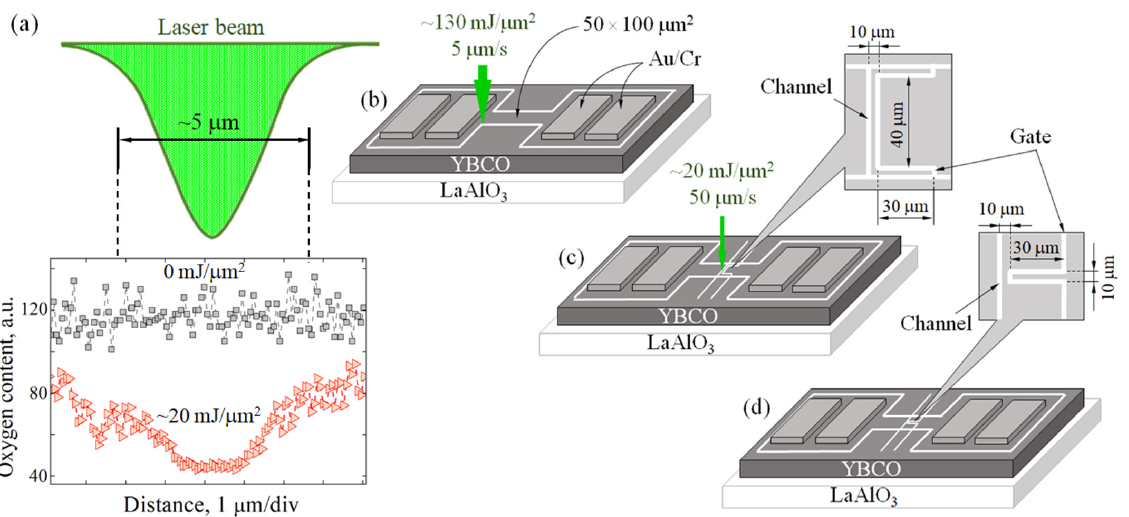
Figure 1. The partially deoxygenated ( δ ~0.2) structures in sample 1 ( c ) and sample 2 ( d ) are created by a laser beam, which produces laser fluence of ~20 mJ/ μ m 2 on the sample surface, scanning it at a speed of 50 μ m/s. The reference sample ( b ) does not have partially deoxygenated structures. About 5 μ m wide insulating lines produced using the same laser with a laser fluence of 130 mJ/ μ m 2 (white thick lines) form the outer contours of the samples. A typical profile of residual oxygen concentration in the film optically modified by the Gaussian laser beam of laser fluence ~20 mJ/ µ m 2 is shown in ( a ). The upper curve of the graph represents the residual oxygen concentration in the optically untreated film area.